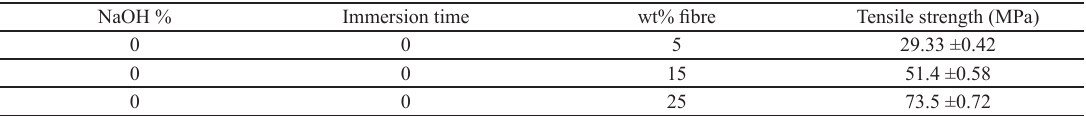
Figure 2. Test bodies manufacturing (a) and tensile testing (b). Table 2. Tensile strength of composites made with untreated fibres.